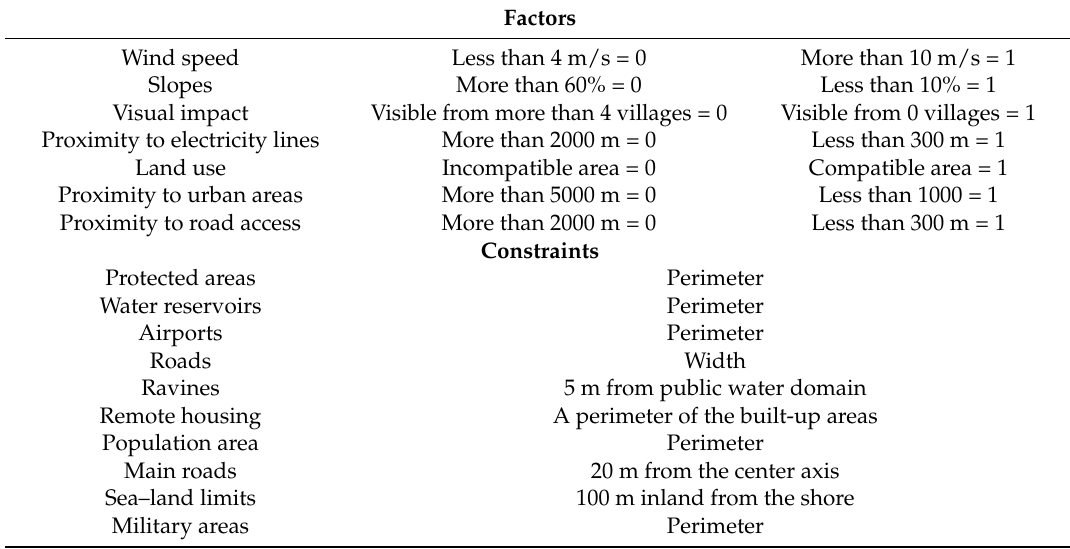
Table 1. Classification of factors and constraints.